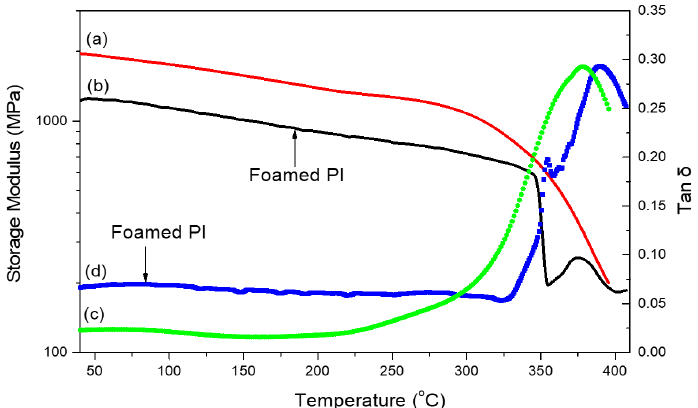
Figure 4. ( a ) Stress–strain curves of neat PI films and OAPS-GO/PI films with different contents of various amounts of OAPS-GO. ( b ) Profile dielectric constants of neat PI films, GO/PI films, and OAPS-GO/PI films [74]. Reproduced with permission from the American Chemical Society. Polymers 2019 , 11 FOR PEER REVIEW